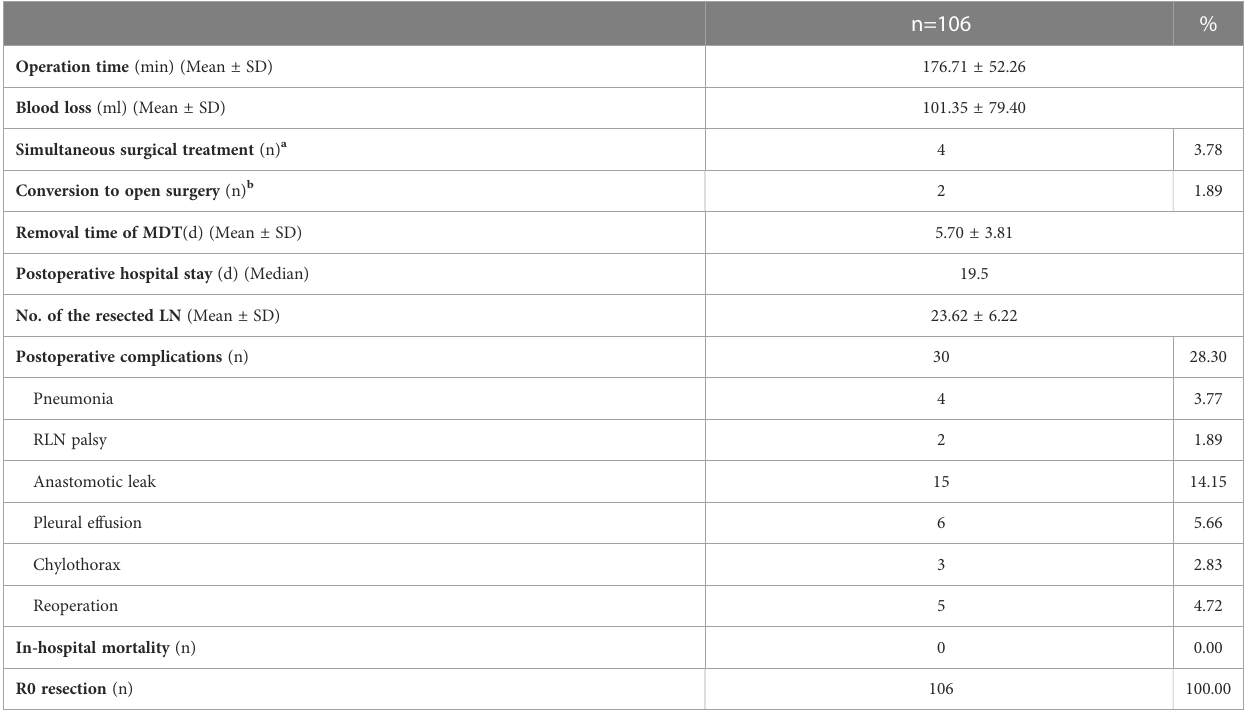
TABLE 2 Perioperative